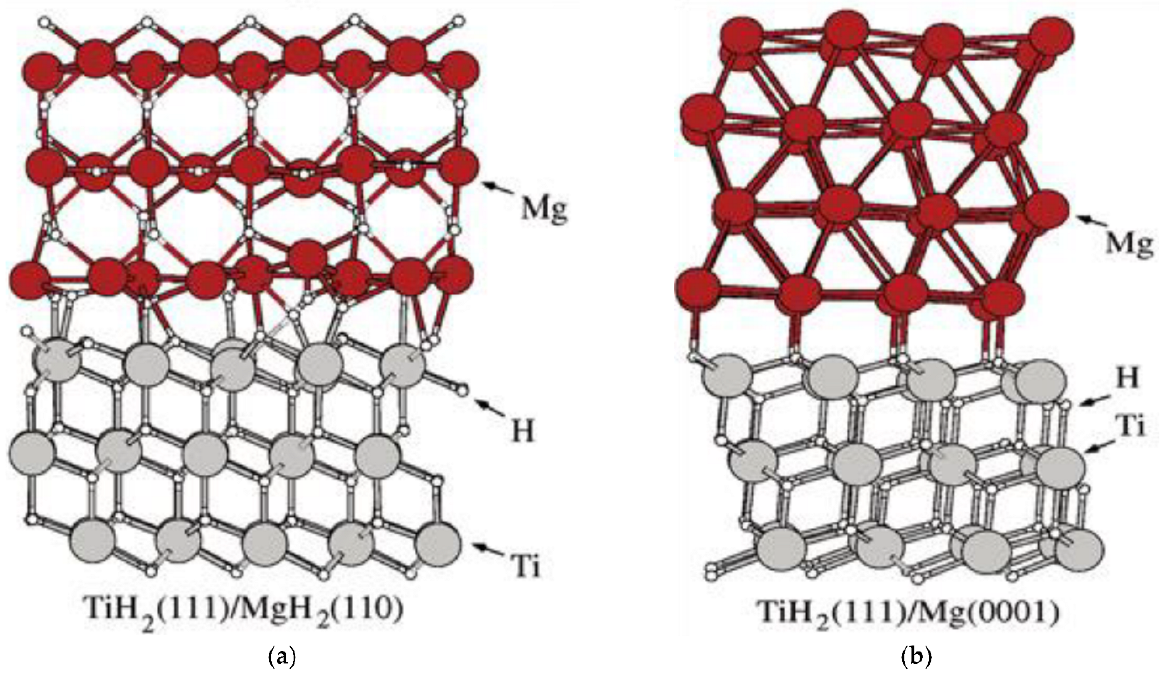
Figure 33. ( a ) Interface structure of TiH 2 (111)–MgH 2 (110). ( b ) Interface structure of TiH 2